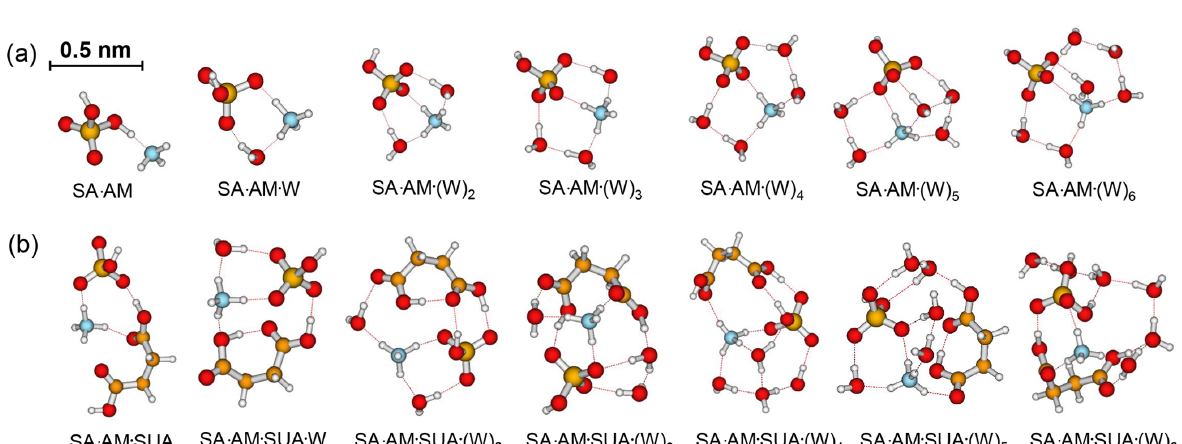
(cid:113) Figure 1. Most stable configurations of the hydrated SA AM clusters and the clusters with one SUA addition. The hydration is with zero to six water molecules. The sulfur (carbon) atoms are depicted as large (small) yellow balls, oxygen atoms in red, nitrogen atoms in blue, and hydrogen atoms in white. The dashed line denotes the hydrogen bond.